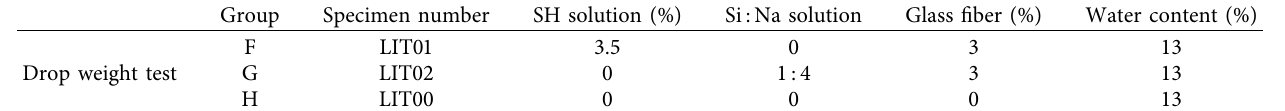
Table 4: Drop weight test plan.